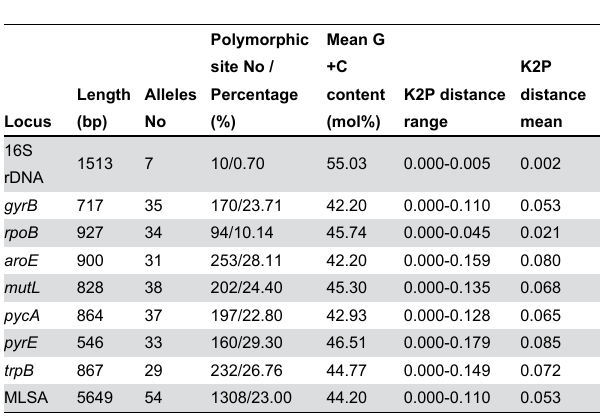
Table 2. Characteristics of the 16S rRNA gene, housekeeping genes and concatenated genes from 79 strains.